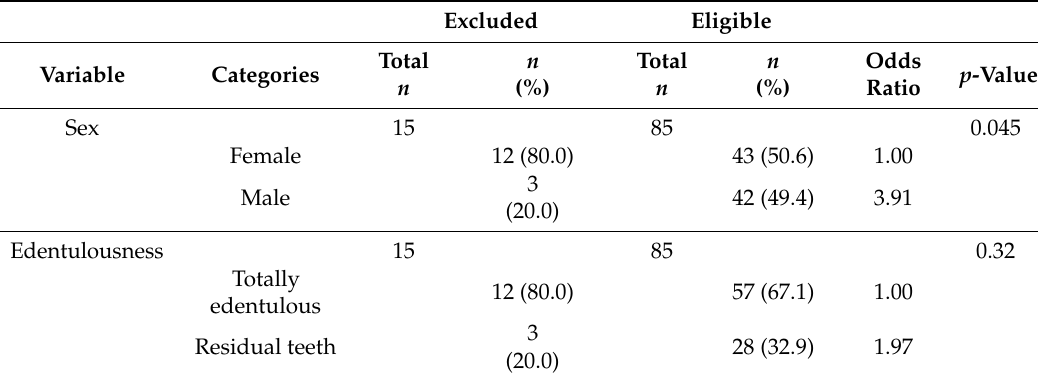
Table 1. Patient eligibility according to sex and type of edentulousness.